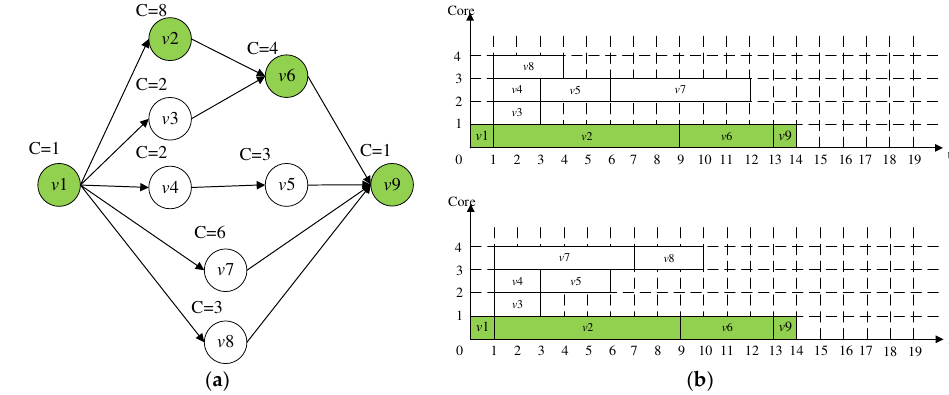
Figure 2. Example of a DAG task; ( a ) A DAG task ( b ) Execution scene.